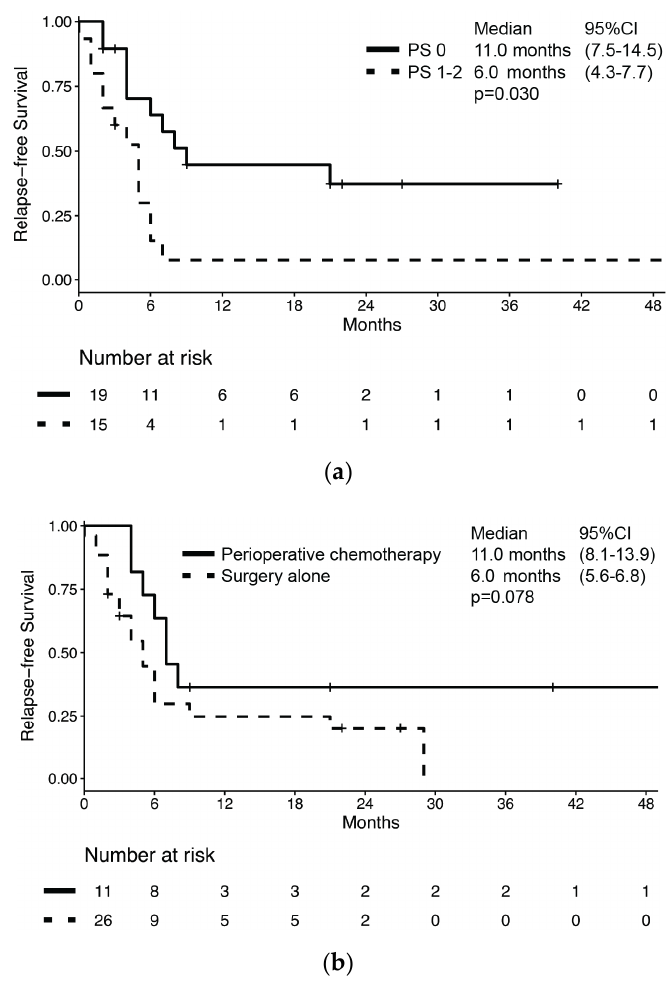
Figure2. Kaplan–Meierestimatesofrelapse-freesurvival(RFS)inbladderNECpatientswhounderwent radical surgery of primary lesion by ( a ) performance status according to ECOG and ( b ) treatment with peri-operative